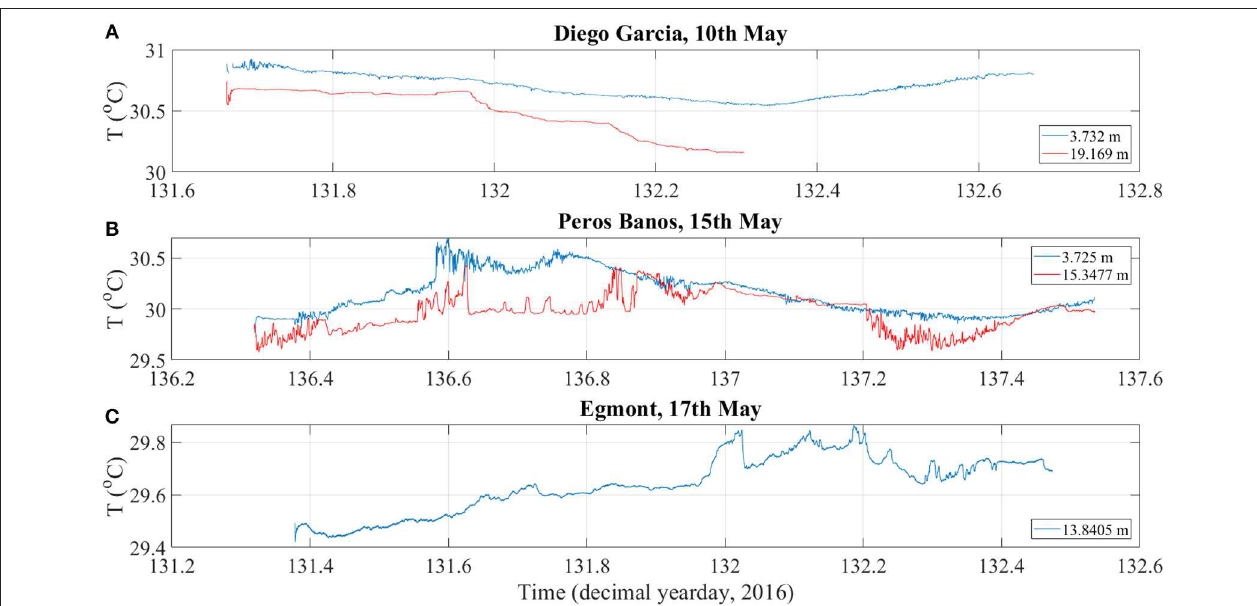
FIGURE 3 | Temperature time series from Valeport miniCTDs deployed at the entrance to (A) Diego Garcia, (B) Peros Banhos, and (C) Egmont lagoons. With the exception of Egmont for which only the deep CTD was recovered, CTDs were located at a depth of approximately 4m and a height above the bed of 2m. For each instrument the mean depth throughout the record is indicated.